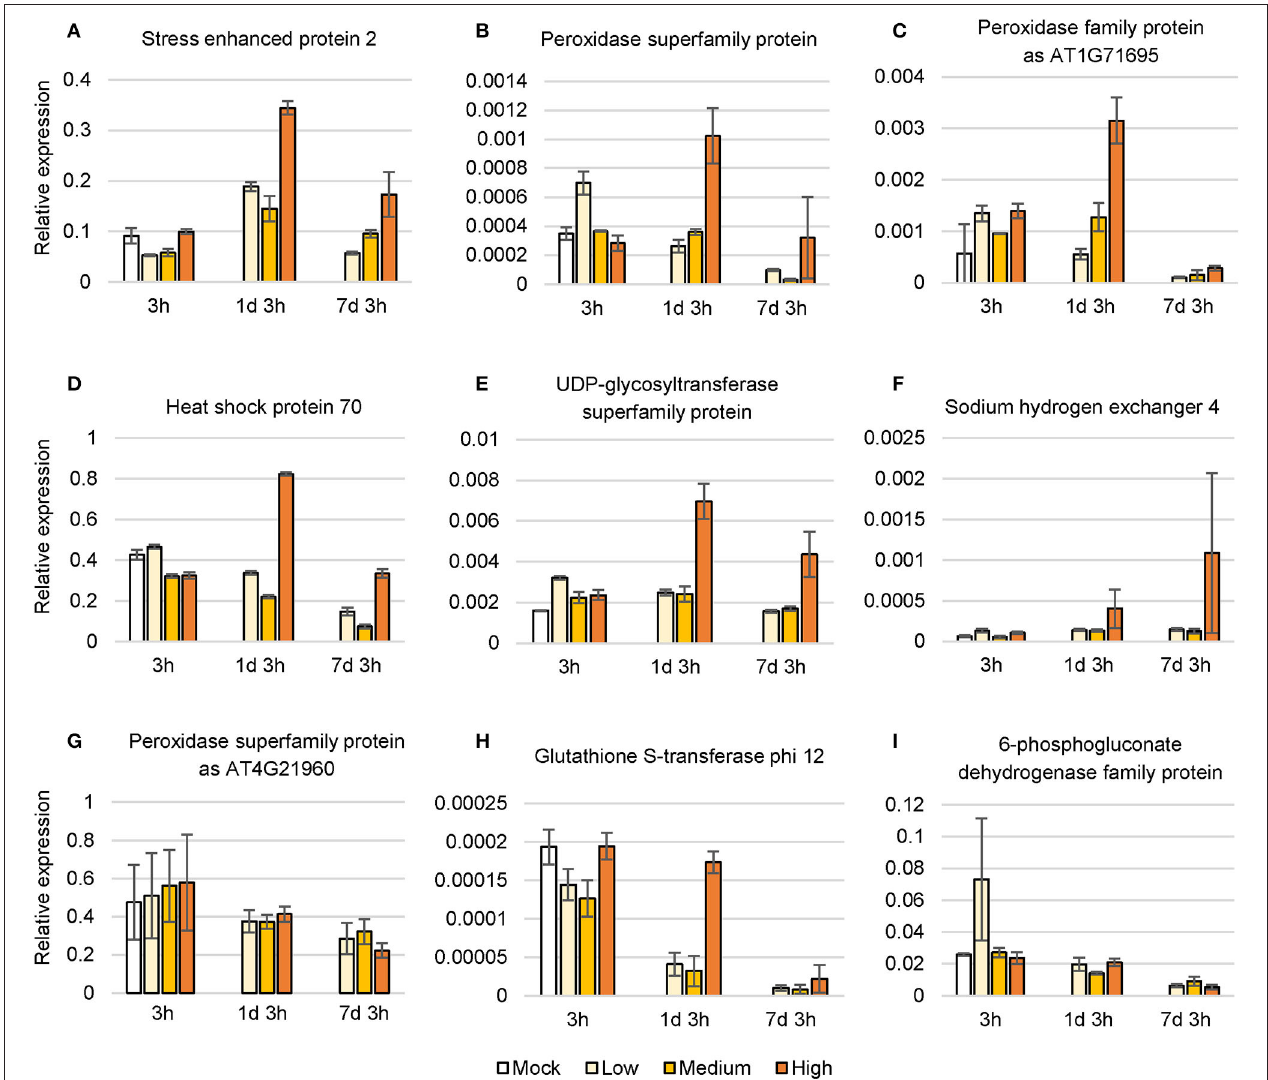
FIGURE 7 | Relative expression level of nine salt response genes under NaCl stress. (A–I) Differentially expressed genes under different saline concentration for the indicated time. H 3 was used as a normalization control. Data are the means of three technical replicates ± SD. Mock, no salt control; Low, low salt stress; Medium, medium salt stress; High, high salt